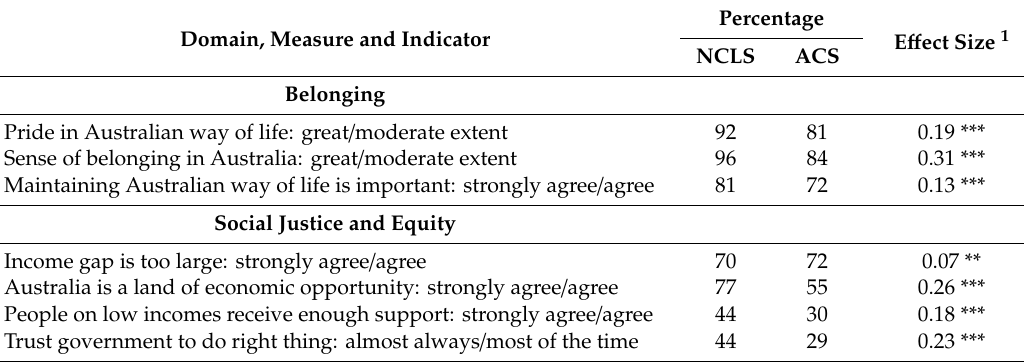
Table 3. Social cohesion indicators, NCLS versus